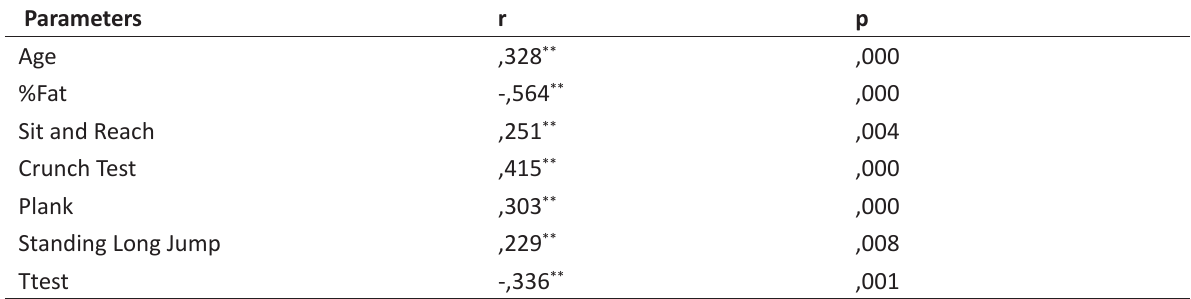
Table 5. Relationship between aerobic endurance and some parameters Parameters